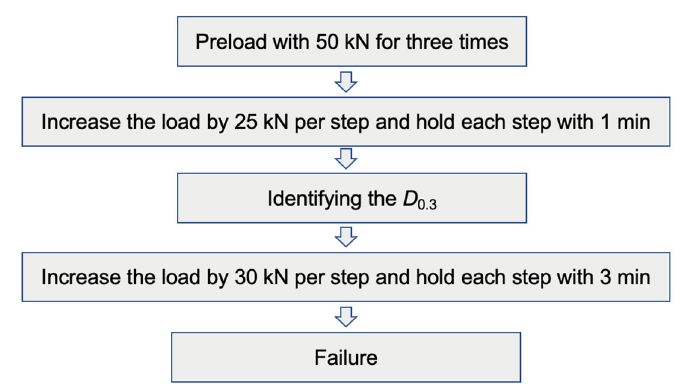
Figure 5. Process flow diagram for the loading control.